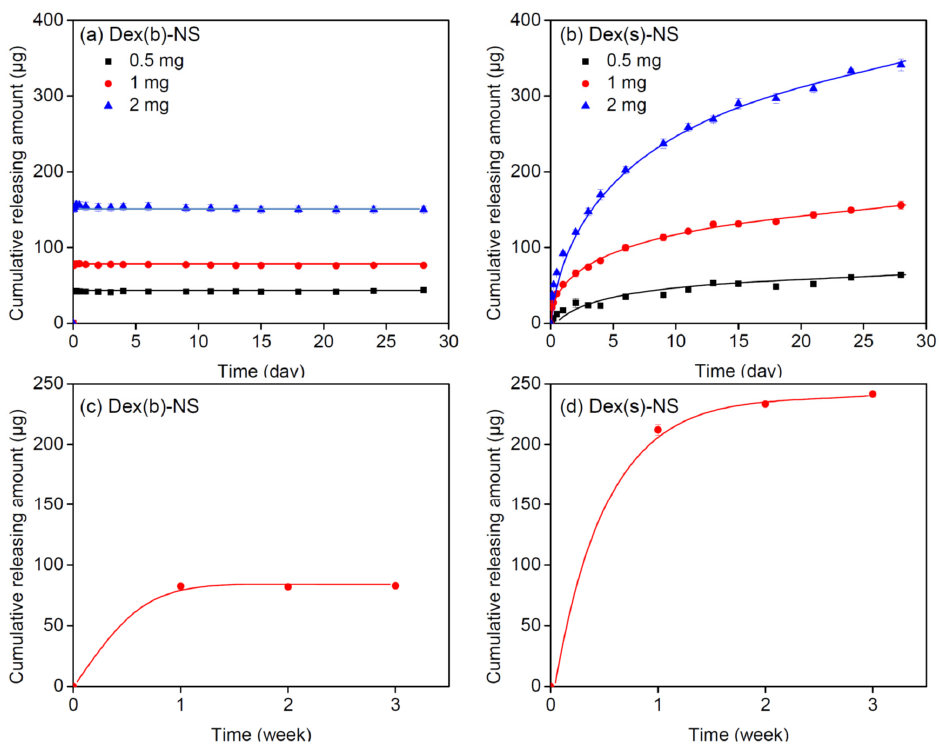
Figure 6. The amount of Dex released from ( a , c ) Dex(b) ‐ NS; and ( b , d ) Dex(s) ‐ NS. ( a , b ) in vitro ; and ( c , d ) in vivo .